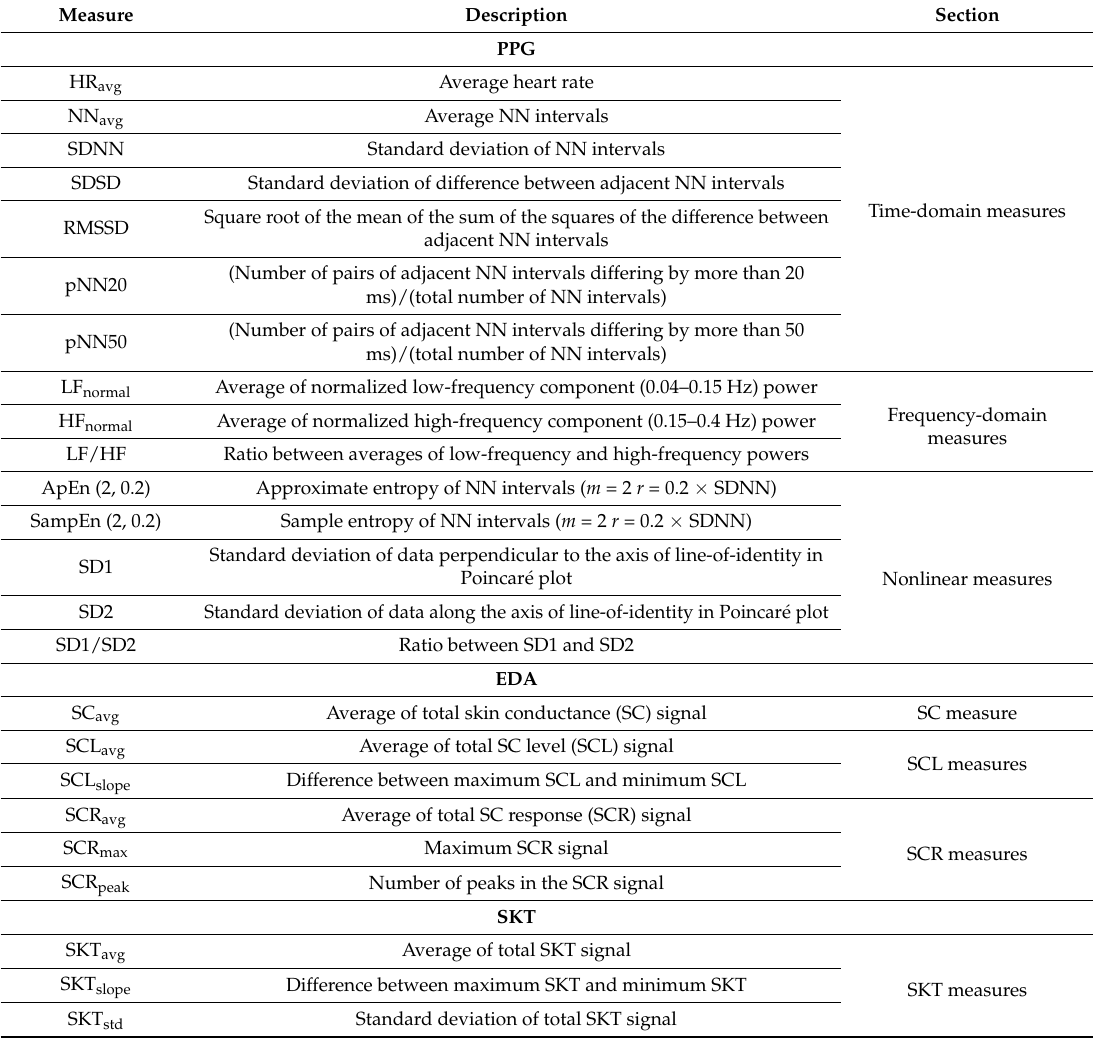
Table 1. All features calculated from measured physiological signals (PPG, EDA and